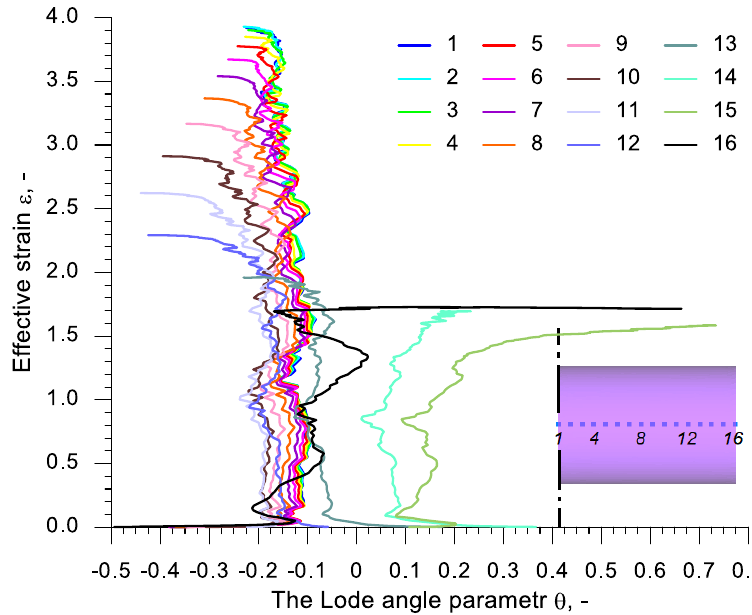
Figure 14. The dependency of effective strain on stress triaxiality in virtual sensors located in the axis of a sample with the length l 0 = 90 mm, subjected to rotational compression.